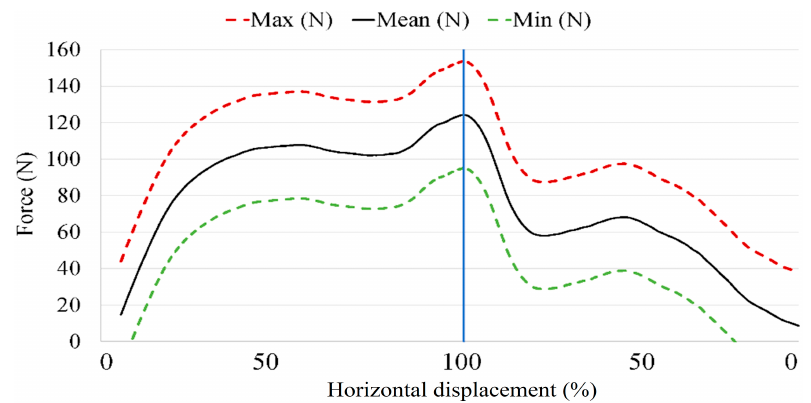
Figure 5. Minimum static force displacement curve of the clutch pedal (Hyundai i30). The abscissa represents the horizontal displacement of the pedal and it is divided into two sides. The left side represents clutch pedal movement from the rest position to the maximum horizontal displacement (0% → 100%), and the right side from the maximum horizontal displacement to the rest position (100% → 0%).